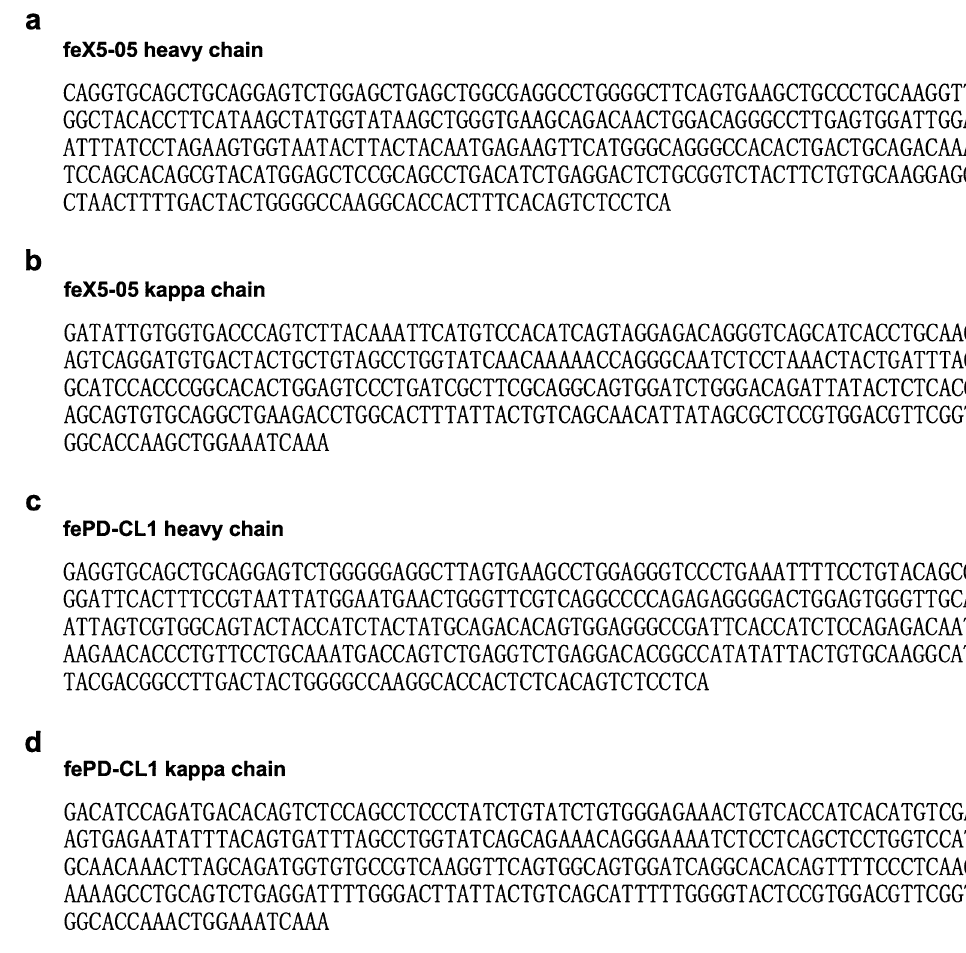
Figure 5. The nucleic acid sequences of variable domains of anti-ferret CXCR5 and PD-1 antibodies. ( a ) The nucleic acid sequences of variable domain of anti-ferret CXCR5 (clone feX5-C05) heavy chain. ( b ) The nucleic acid sequences of variable domain of anti-ferret CXCR5 (clone feX5-C05) kappa chain. ( c ) The nucleic acid sequences of variable domain of anti-ferret PD-1 (clone fePD-CL1) heavy chain. ( d ) The nucleic acid sequences of variable domain of anti-ferret PD-1 (clone fePD-CL1) kappa